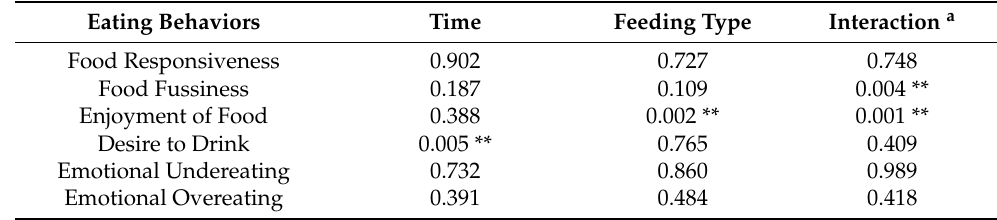
Table 2. Repeated measures ANCOVA shows that there was a statistically significant interaction between feeding modality and time from 12 to 24 months for food fussiness and enjoyment of food. Model includes the covariates maternal pre-pregnancy BMI (kg/m 2 ), infant breast milk feedings per day, infant formula feedings per day, infant sex, infant birth weight (kg), mode of delivery, and socioeconomic status index (SES). Eating Behaviors Time Feeding Type Interaction a Food Responsiveness 0.902 0.727 0.748 Food Fussiness 0.187 0.109 0.004 ** Enjoyment of Food 0.388 0.002 ** 0.001 ** Desire to Drink 0.005 ** 0.765 0.409 Emotional Undereating 0.732 0.860 0.989 Emotional Overeating 0.391 0.484